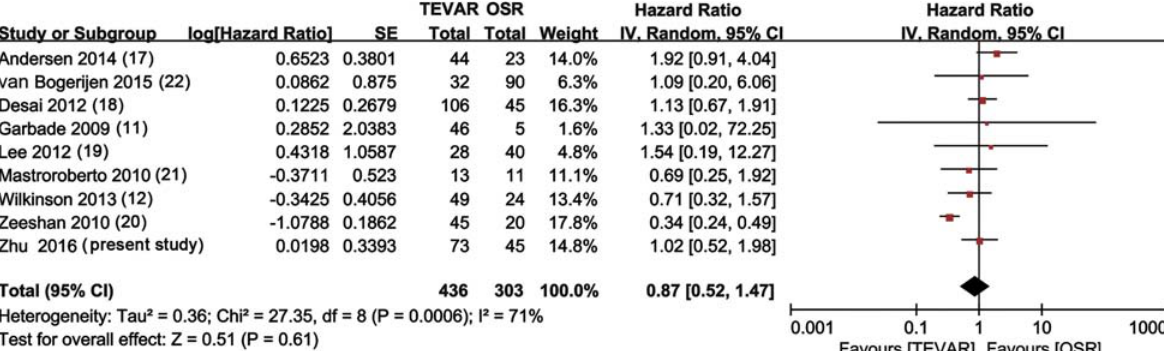
Figure 2. Meta-analysis of long-term overall survival rate between open surgical repair (OSR) and thoracic endovascular aneurysm repair (TEVAR) in patients with type-B aortic